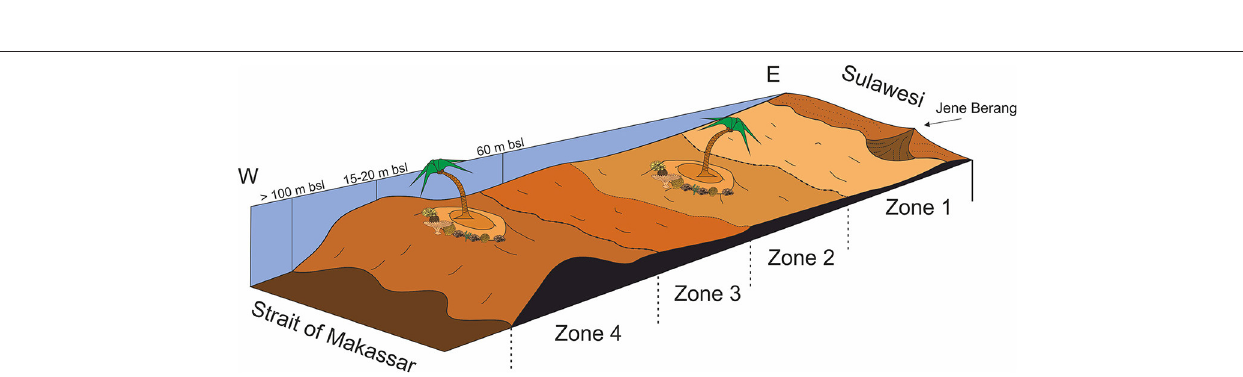
FIGURE 10 | Schematic profile through the Spermonde Shelf following the zonation suggested by De Klerk (1982) and Troelstra et al. (1996). Nearshore factors controlling the spatial zonation are anthropogenic activities and river discharge. With increasing distance to the mainland, factors such as water depth, salinity, nutrient availability, and ocean currents become more